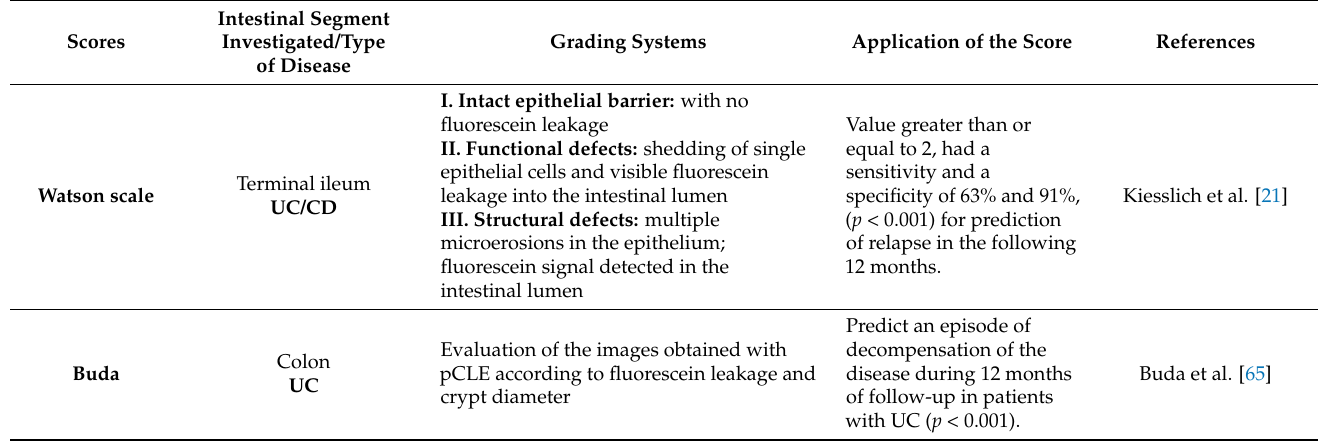
Table 2. CLE scores regarding inflammatory lesions and prediction of the recurrence of the